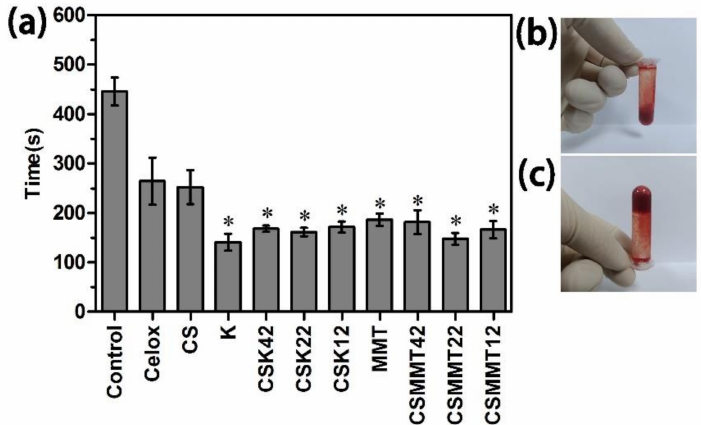
Figure 5. ( a ) In vitro blood clotting time of control, Celox, CS, K, CSK42, CSK22, CSK12, MMT, CSMMT42, CSMMT22, and CSMMT12. Data represent the mean ± SD ( n = 3). * p < 0.05 compared to Celox. ( b , c ) Coagulation state of in vitro